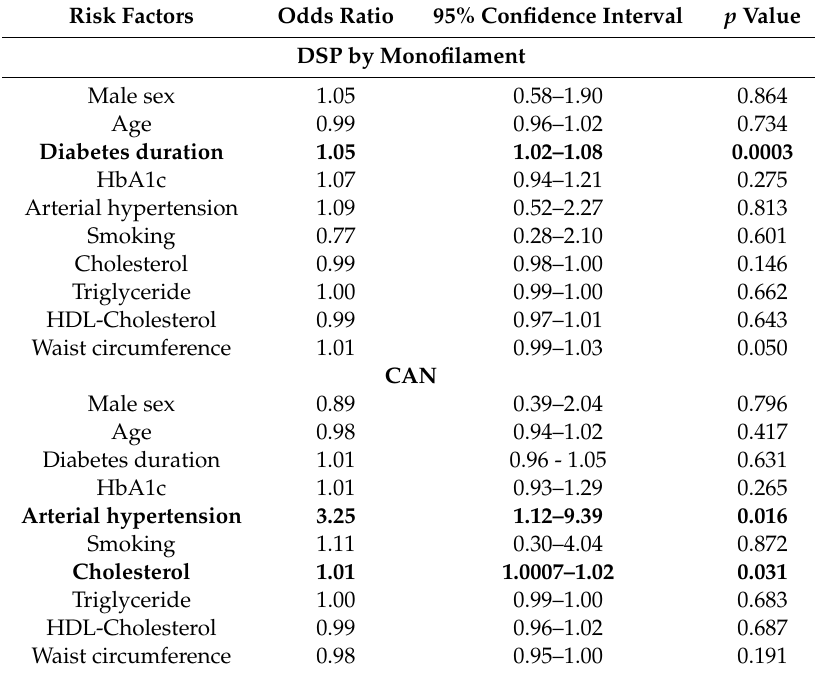
Table 3. Multivariate analysis of risk factors for distal symmetric polyneuropathy (DSP) and for cardiovascular autonomic neuropathy